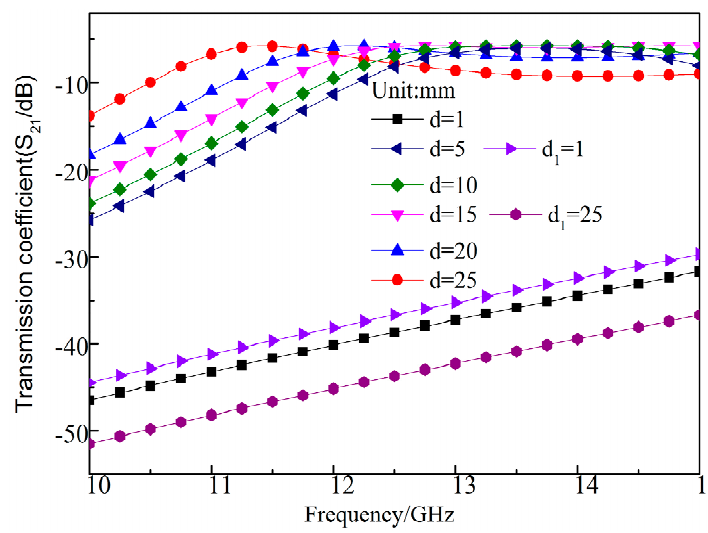
Figure 15. Transmission coefficient of Cas for various distances.